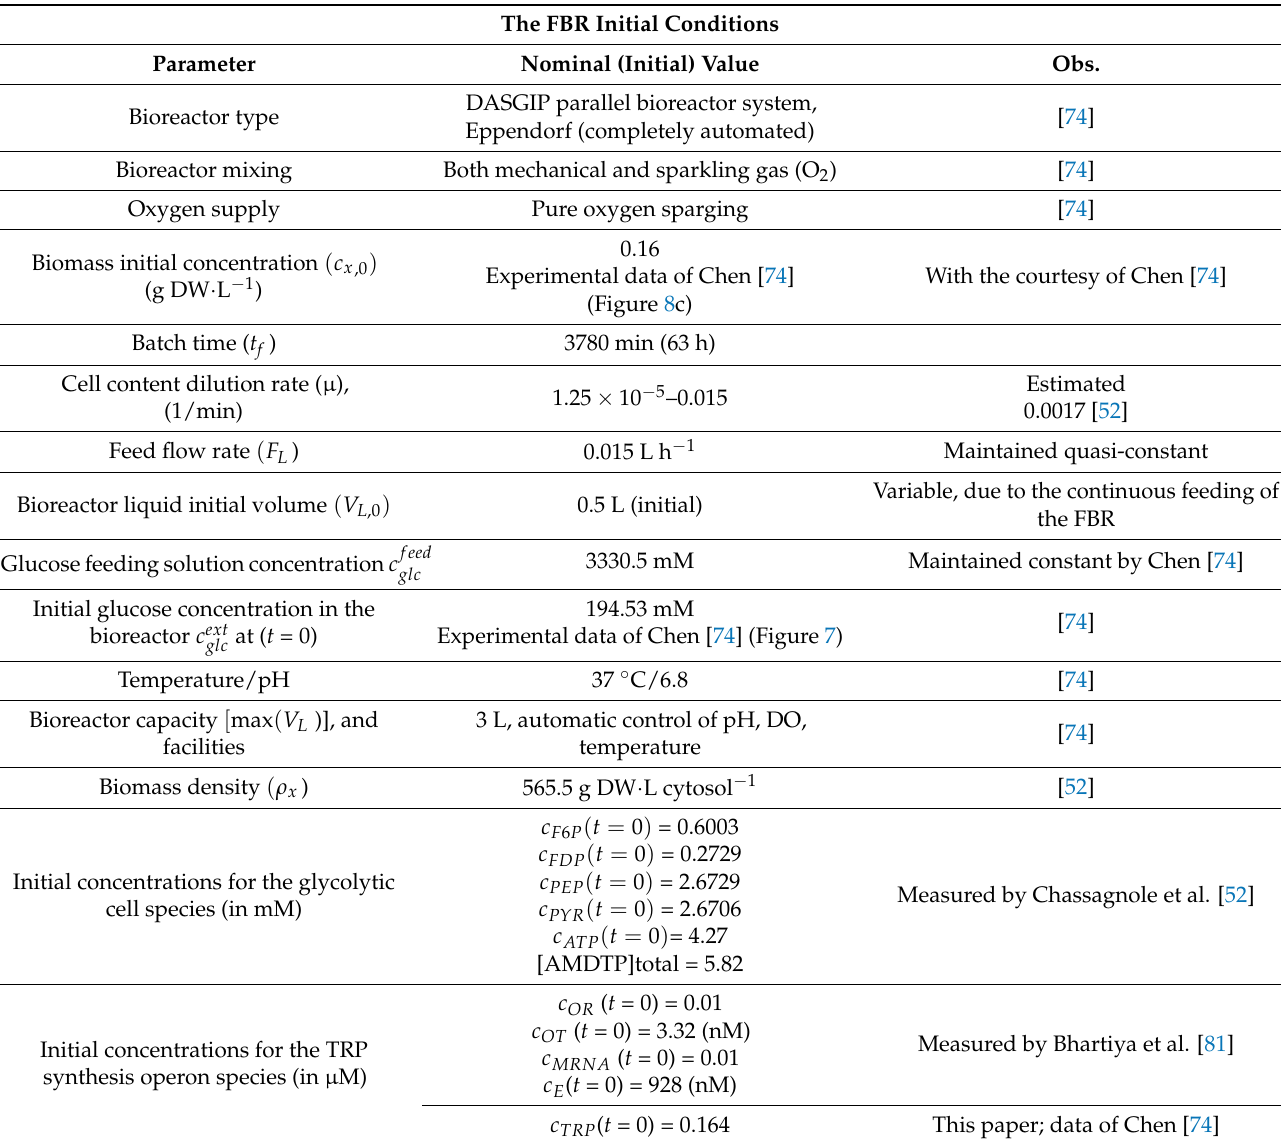
Table 1. The nominal initial operating conditions of the FBR used by Chen [74] to collect the kinetic data of the TRP synthesis using a suspended culture of genetically modified E. coli cells (T5 strain). More experimental details were given by Chen